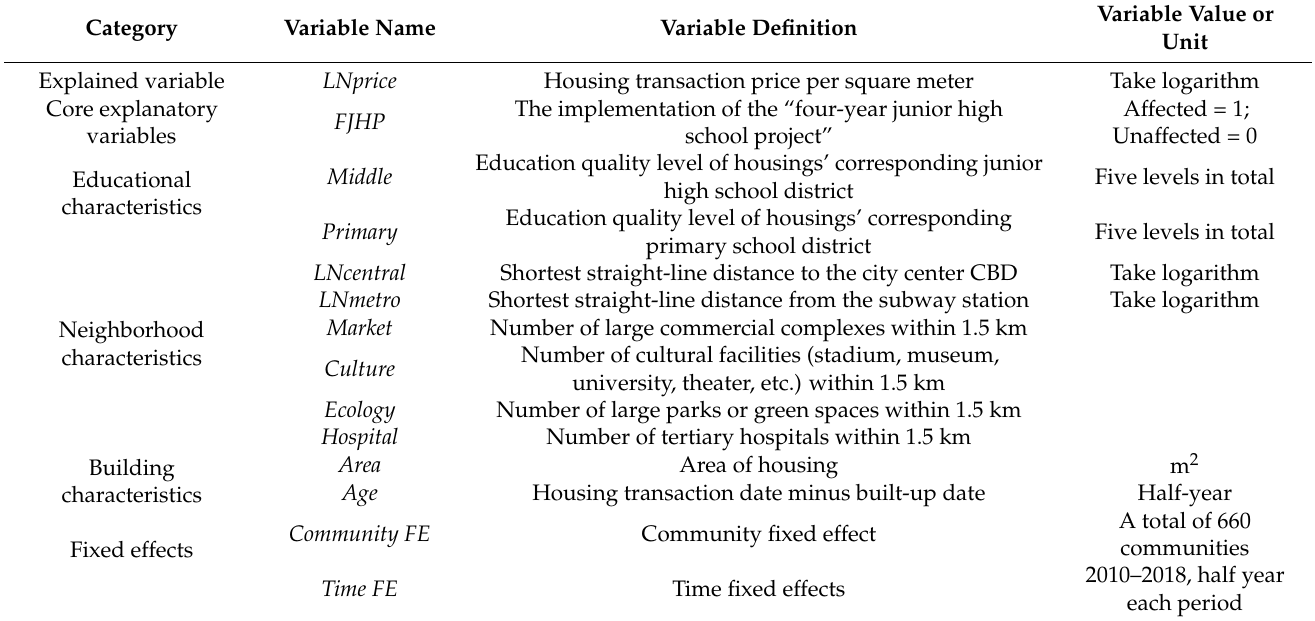
Table 1. Variable